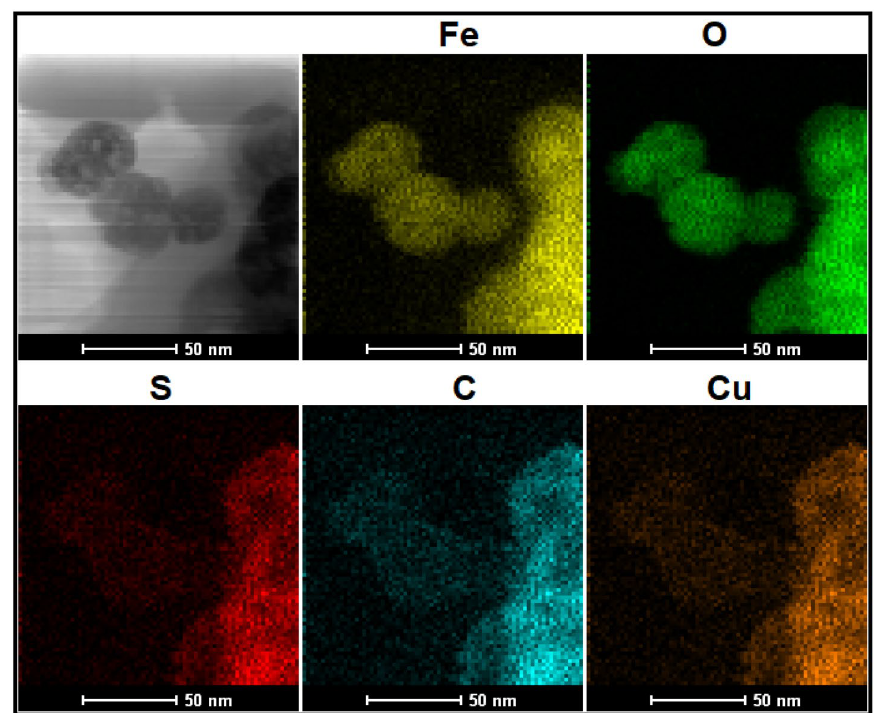
Figure 5. TEM mapping of Fe 3 O 4 @HKUST-1.